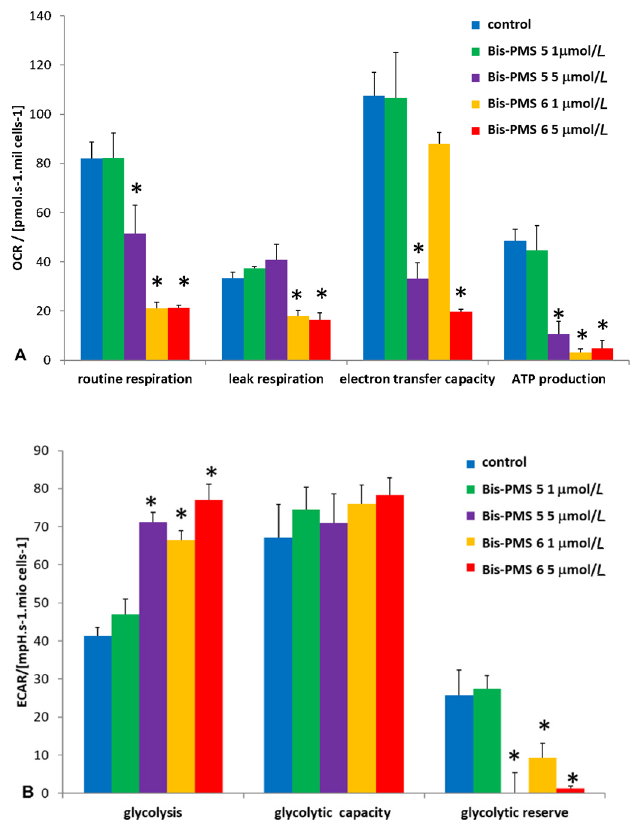
Figure 7. Influence of Bis-PMS on the energy metabolism in A2058 melanoma cells. A Seahorse Bioanalyzer was used to evaluate mitochondrial respiration ( A ) and glycolysis ( B ) in A2058 cells exposed to 1 and 5 µ mol/L of Bis-PMSs 5 and 6 for 2 h. * p < 0.01 vs. control, n = 4, one-way ANOVA followed by a Tukey’s post hoc test. OCR = oxygen consumption rate, ECAR = extracellular acidification rate.